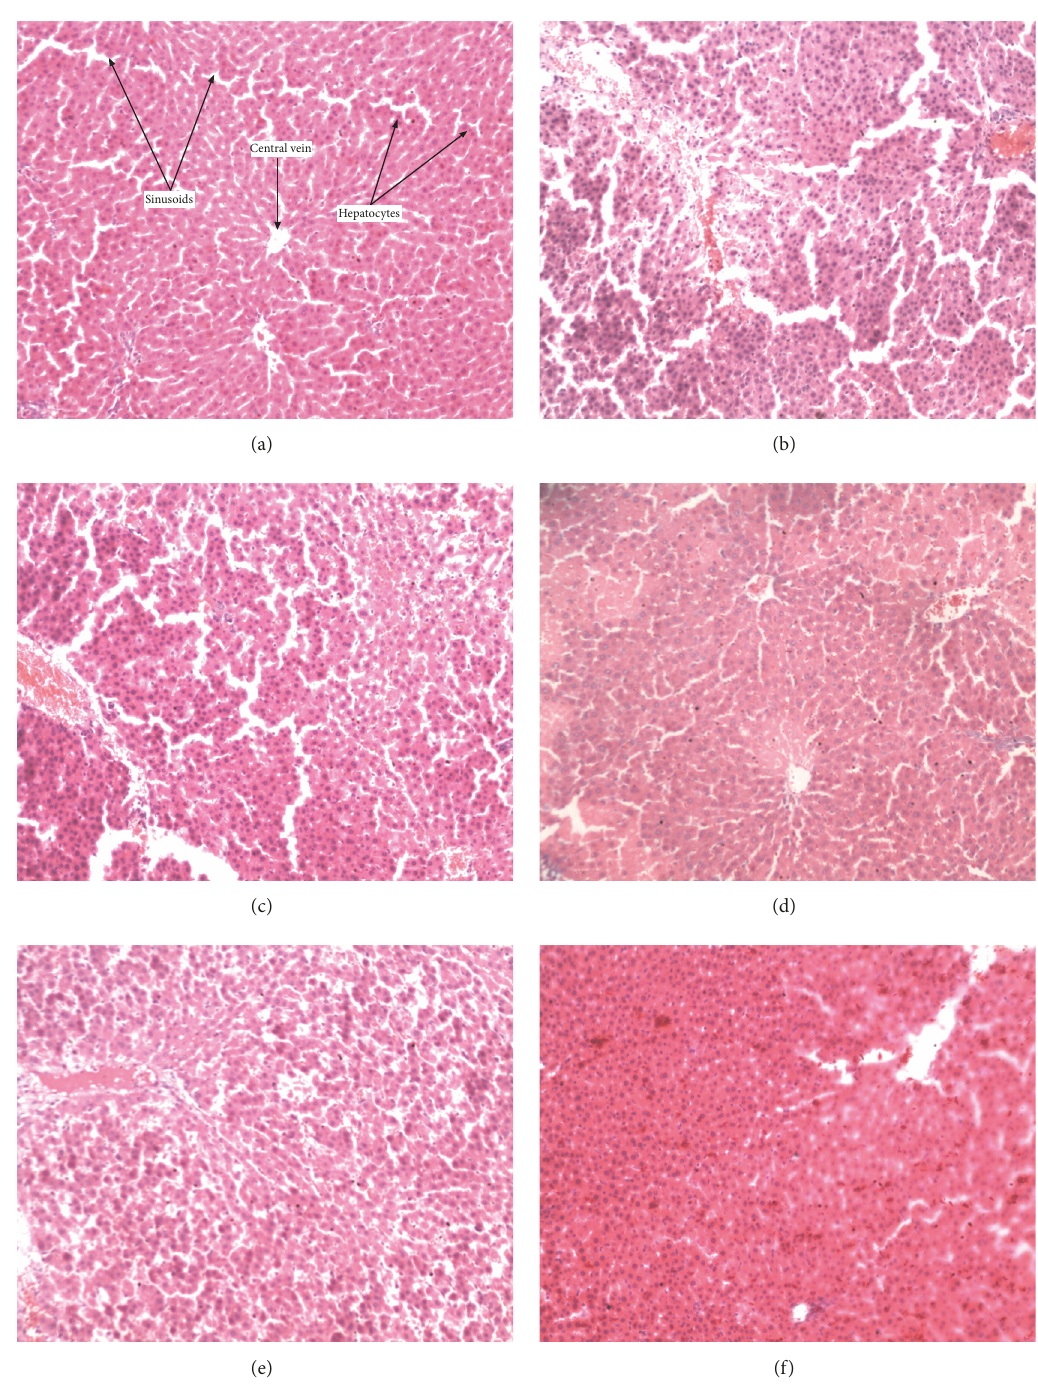
Figure 3: Photomicrograph of the sections of the liver in control rats (a) and rats treated orally with 30 mg kg −1 (b), 100mg kg −1 (c),